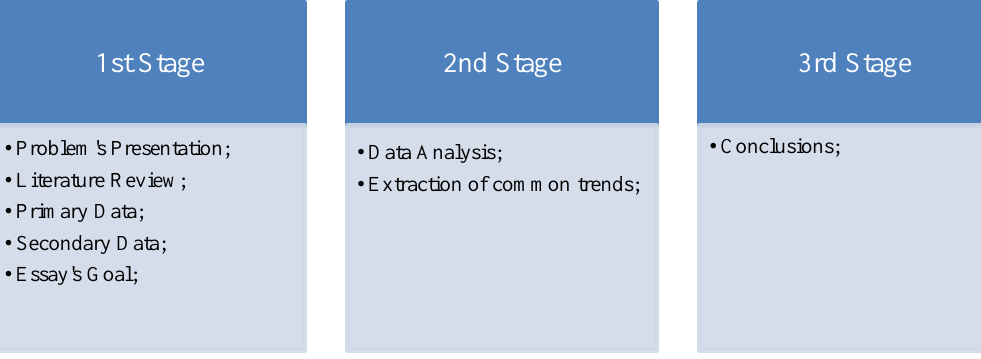
Figure 1. Flowchart of the research